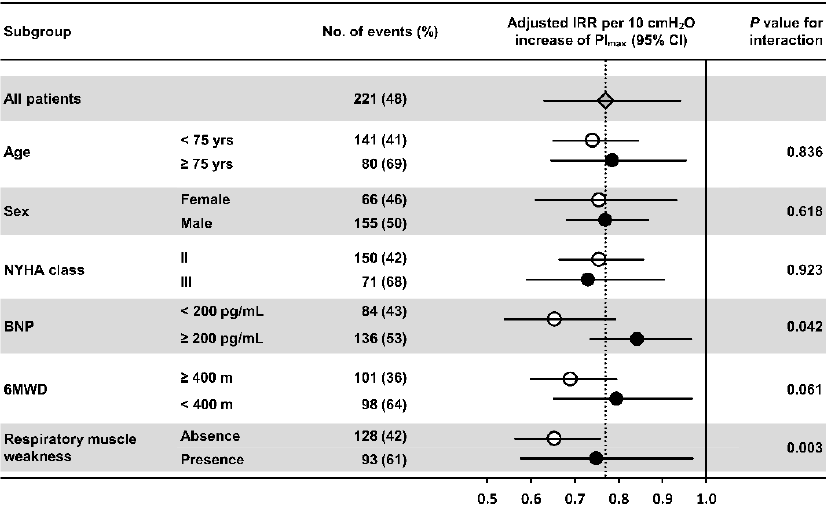
Figure 4. Unadjusted rates of all-cause clinical events and cardiovascular events according to categories of change in PI max per 10 cmH 2 O. White bars, all-cause events; black bars, cardiovascular events. PI max , maximal inspiratory pressure.